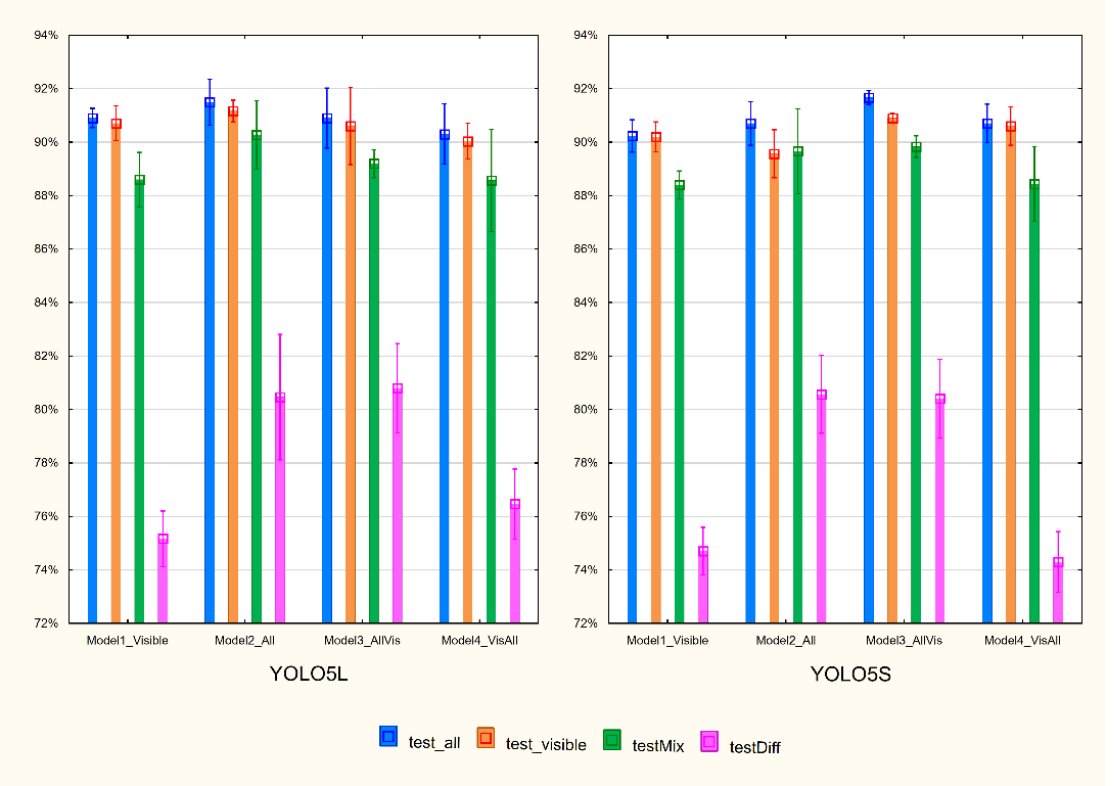
Figure 3. Mean and standard deviation of mAP@.5:.95 for three runs of each model evaluated on four different test datasets.